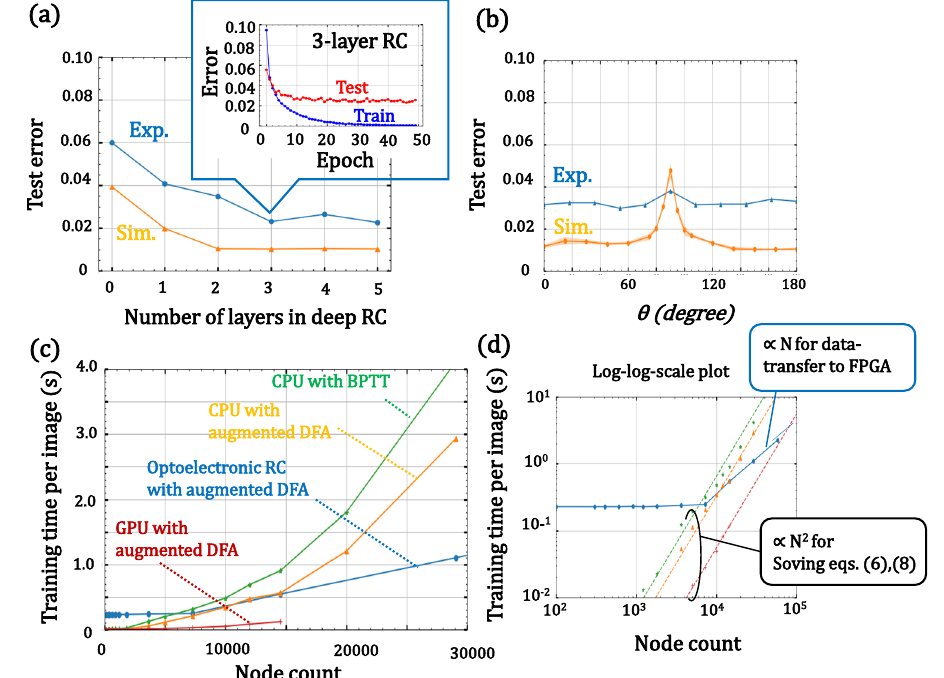
Fig. 4 | Performance ofoptoelectronic deep RCsystem. a Training accuracyas a function of layer number in RC with 606 nodes. Blue and orange plots show the results for the constructed benchtop and simulation on a CPU. Inset in a shows trainingandtestaccuracyundertraining. b Testerrorofthe4-layeredRCwith404 nodes as a function of η . The accuracy is robust against the shape of g ( a